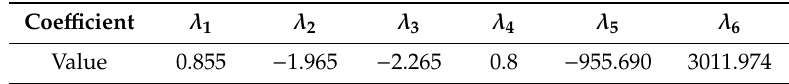
Table 1. The enthalpy calculation coe ffi cient of calcium chloride [27]. Reproduced from [28], International Journal of Thermal Sciences: 2003.